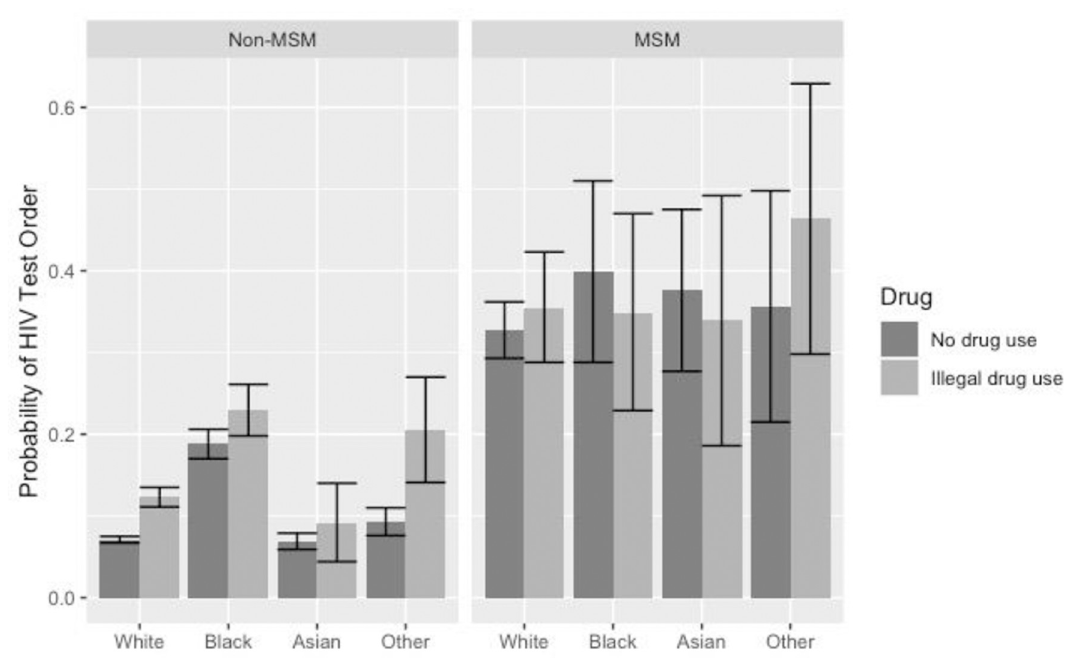
Fig 1. Predicted probability of HIV test ordering by MSM v non-MSM, race, and Illegal drug use status. The probabilities of HIV test ordering estimated from regression GEE modeling were adjusted for patient age, group (MSM vs non-MSM), race, PCP department, time, alcohol use and illegal drug use. Interactions of group � race, group � illegal drug use and race � illegal drug use were included, the group � race � drug use interaction was not significant.